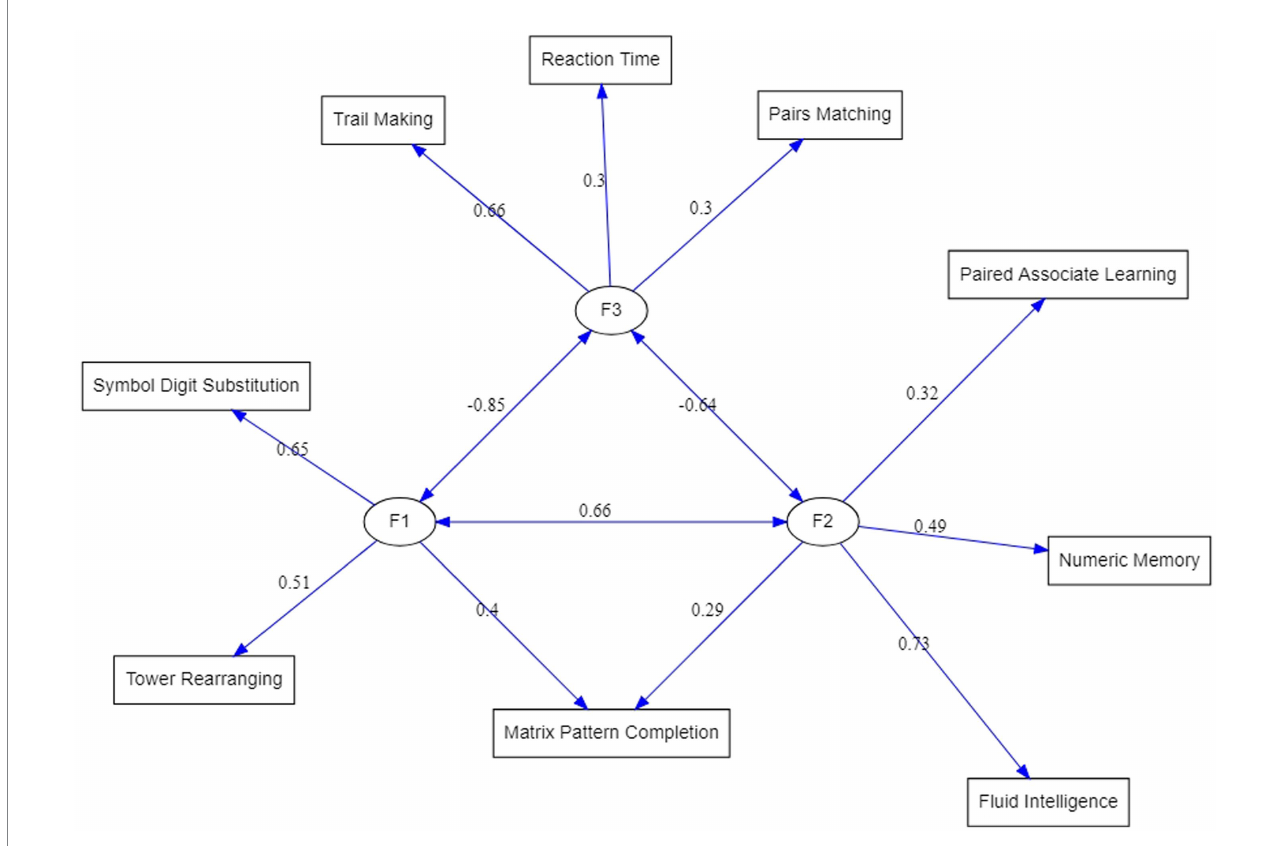
FIGURE 2 ESEM-reconstructed factorial structure of the cognitive test variables from the UK Biobank. Circles represent factors. The double-sided arrows indicate